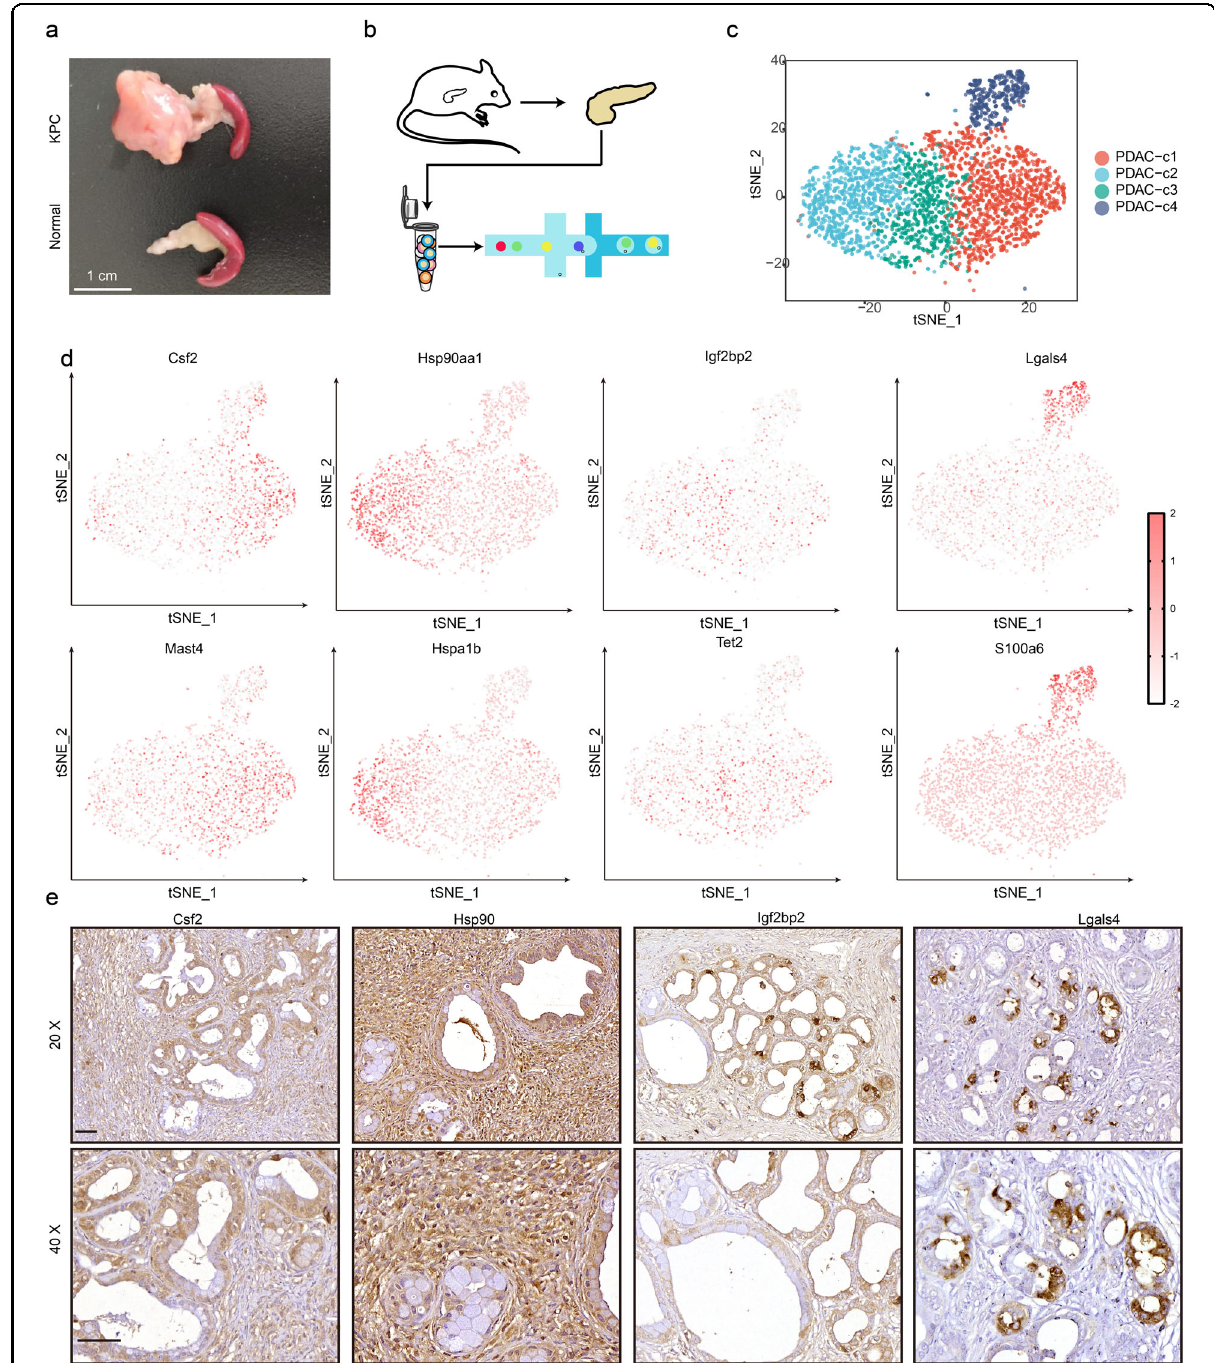
Fig. 1 Single-cell RNA sequencing analysis of tumors derived from KPC mice. a The comparison of pancreas size from KPC mice and the littermate control. b Procedure of KPC tumors for single-cell RNA sequencing. c The t-distributed stochastic neighbor embedding (t-SNE) plot of KPC cells. d Expression levels of representative markers for the four types of KPC tumor cells. e Representative marker IHC staining of four PDAC clusters. Scale bar, 50 μ